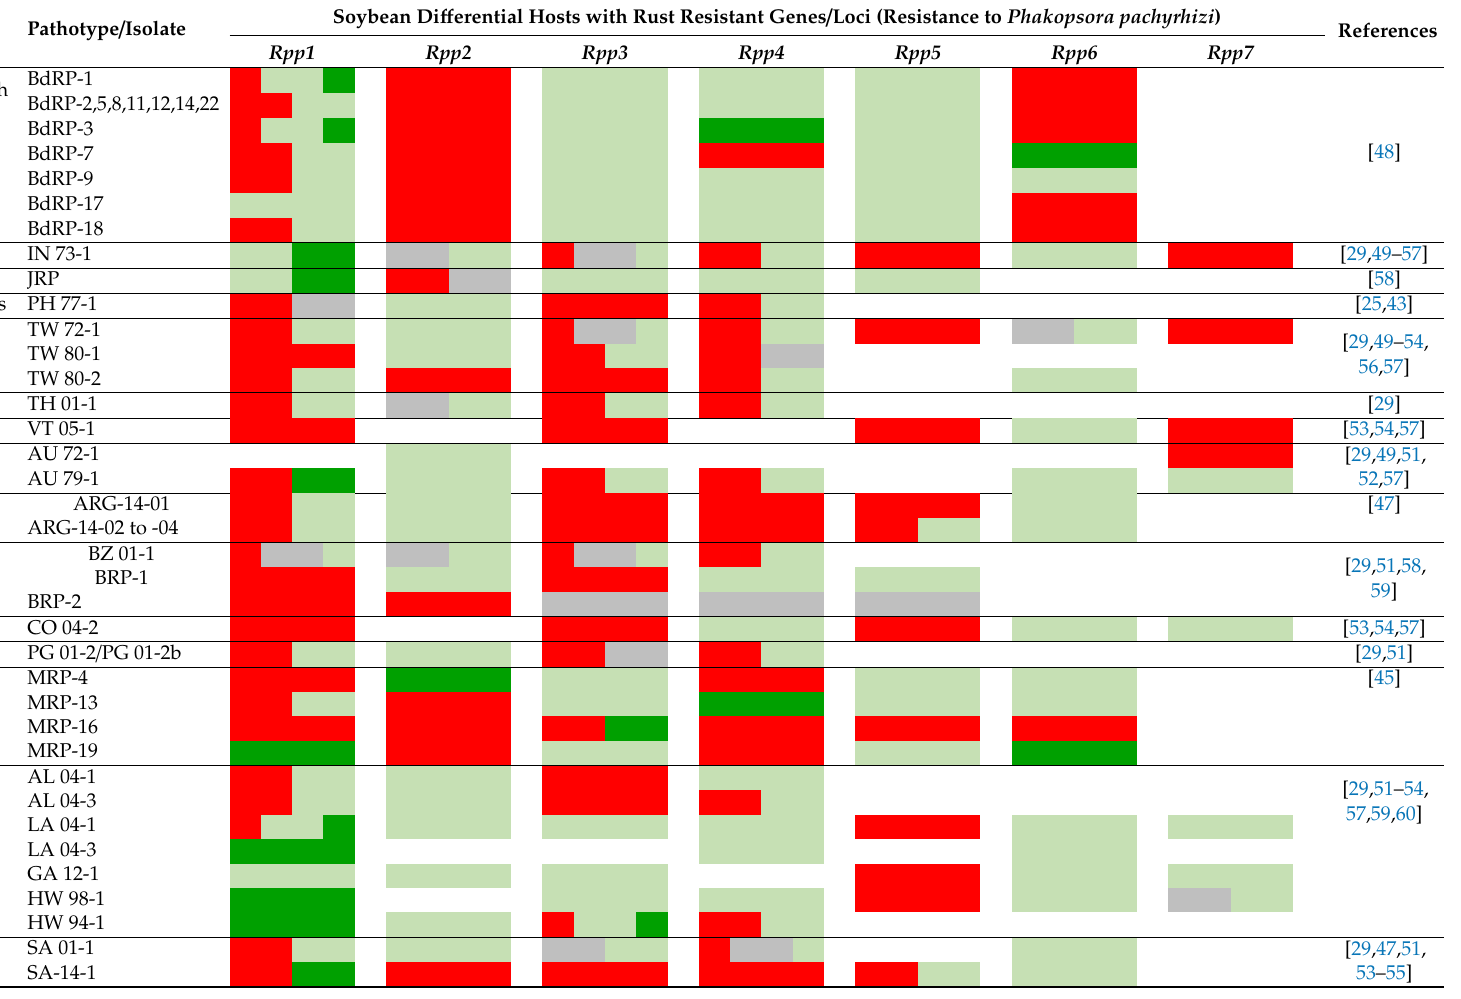
Table 1. Phenotypic reactions of global soybean rust isolates to di ff erent Rpp genes soybean di ff erential